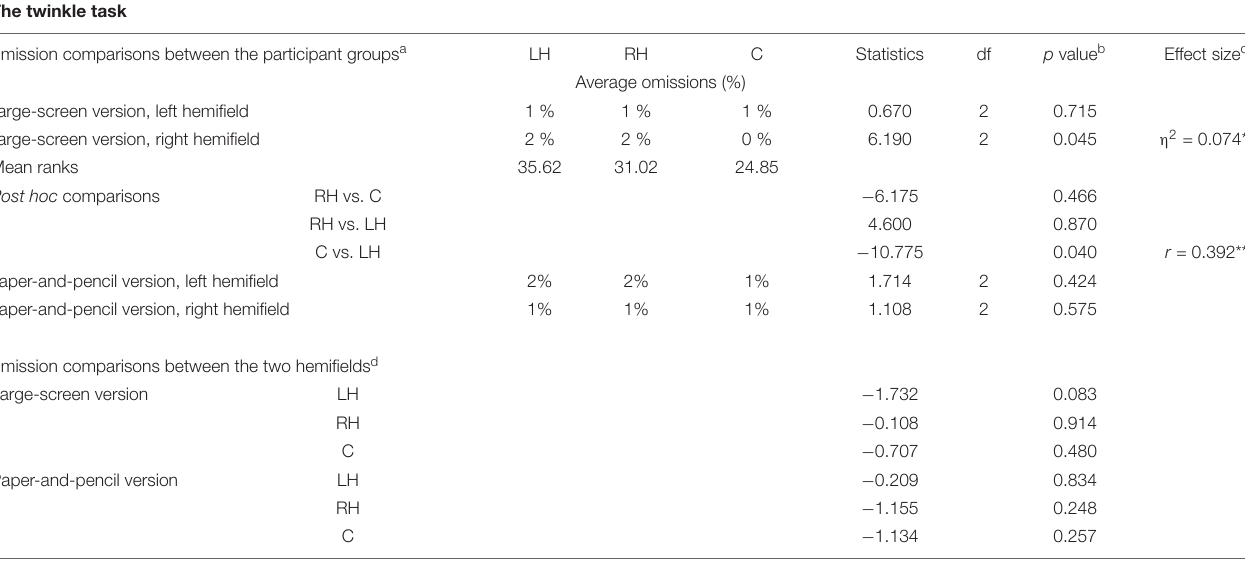
TABLE 2 | Average omissions, and related statistical group comparisons in the two versions of the cancellation task (computerized with large screen or paper and pencil). The twinkle task Omission comparisons between the participant groups a